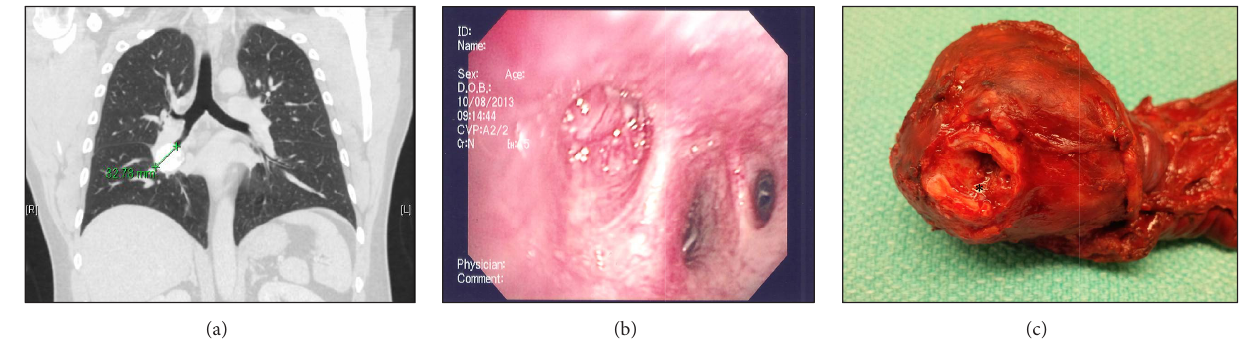
Figure 1: (a) CT thorax, coronal slice demonstrating a radiopaque hilar mass; (b) the hypervascular mass, as seen under bronchoscopic exam, occluding the bronchus; (c) the right middle lobe resection specimen. The mass encases the bronchial resection margin. The fleshy, endobronchial portion ( ∗ ) was sampled at the time of frozen section.